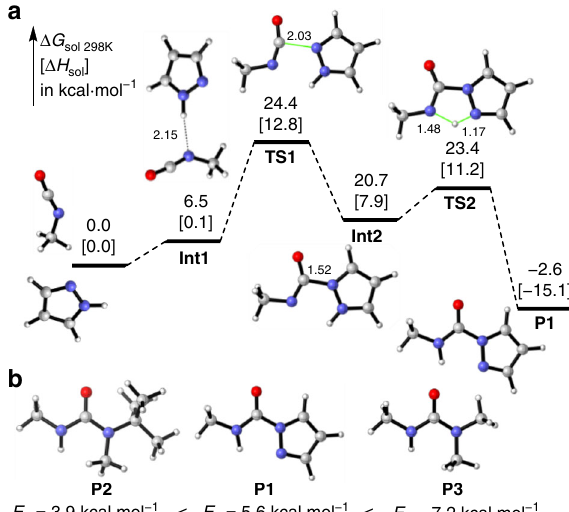
Fig. 2 Theoretical investigations for the formation and dynamicity of PzUBs.